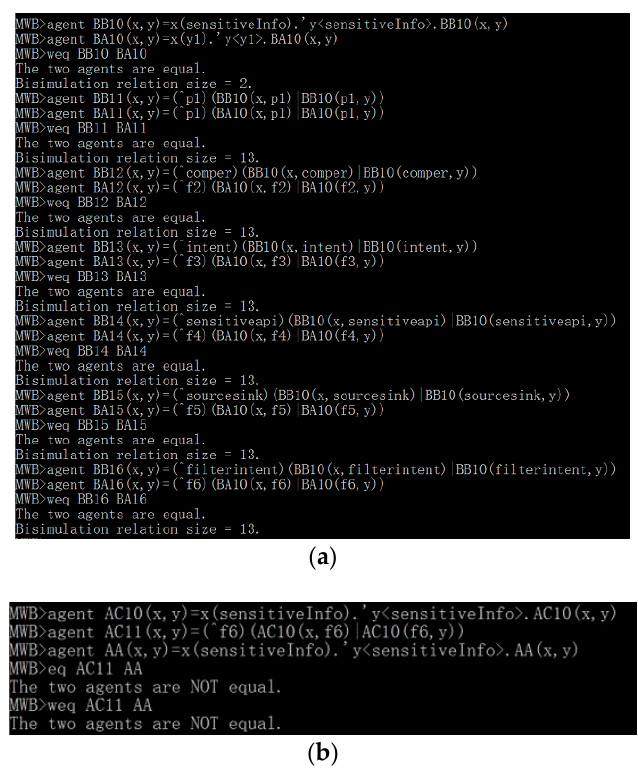
Figure 4. ( a ) Weak equivalence relationship verified; ( b ) Non-equivalence relationship verified.